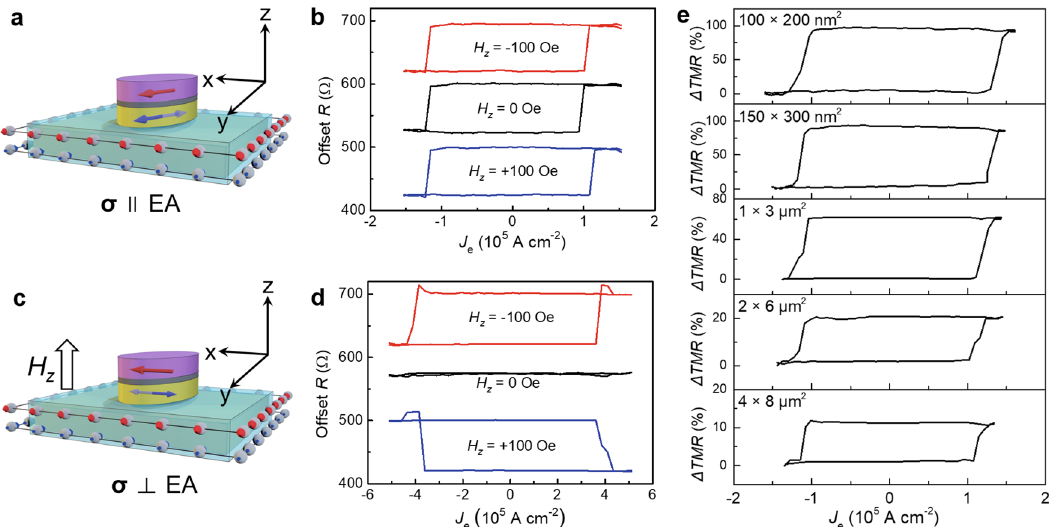
Fig. 2 Current-driven SOT switching. a , b show the SOT switching for the collinear case between the spin polarization ( σ ) and the easy axis ( σ ∥ EA). b The current-driven SOT switching shows the deterministic switching without external magnetic fi eld, i.e., fi eld-free switching, where the magnetic fi eld H z has not effect on the switching polarity. c , d show the SOT switching for the orthogonal case of σ ⊥ EA, where a H z is needed for deterministic switching. d For the σ ⊥ EA case, an external magnetic fi eld H z is needed to break the mirror symmetry between + m x and − m x for deterministic SOT switching, as indicated by the opposite SOT switching polarities under H z = ±100 Oe. e , SOT switching for the MTJ scaling down from 4 µ m × 8 µ m to 100 nm × 200 nm ( σ ∥ EA).